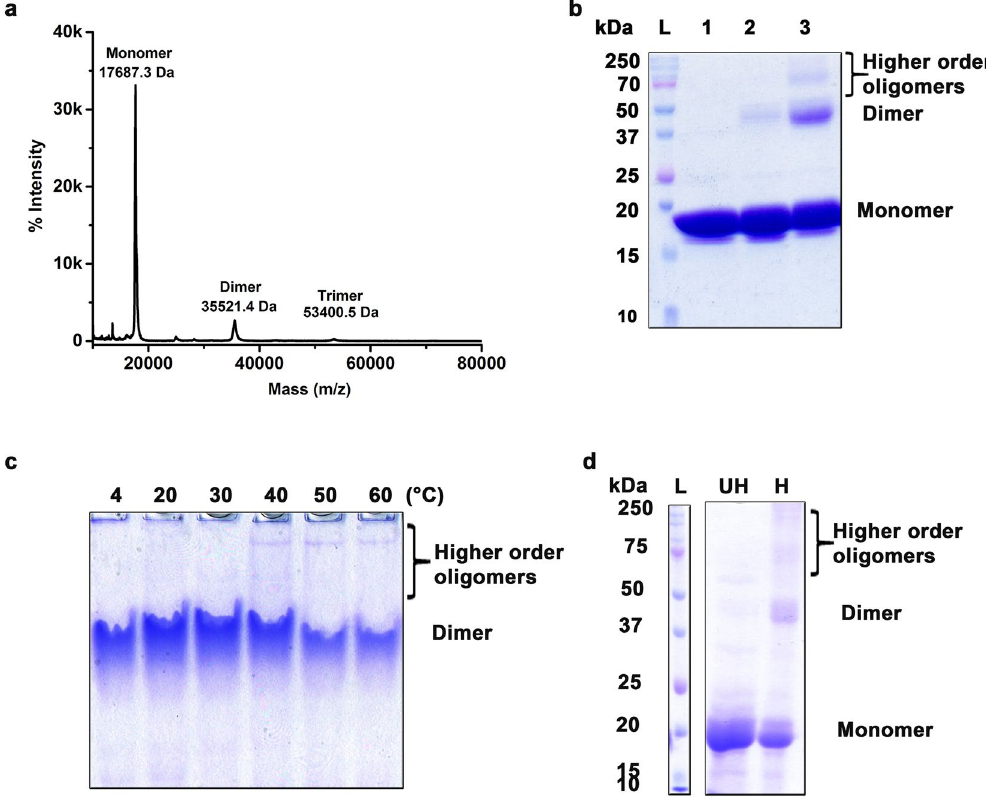
Figure 5. CarD has the tendency to form higher order oligomers in solution. ( a ) MALDI-TOF based intact mass spectrum analysis of CarD (50 μ M) shows the presence of monomeric (17.687 kDa), dimeric (35.521 kDa) and trimeric (53.400 kDa) species. ( b ) Chemical cross-linking experiments performed using BS 3 demonstrates that CarD (50 μ M) has a tendency to form dimers, and higher order oligomers in solution. Lane 1, CarD in absence of BS 3 ; lane 2, and 3, CarD in presence of 30-fold and 50-fold molar excess of BS 3 respectively. L denotes the molecular weight ladder used as a standard. ( c ) CarD samples (50 μ M) were incubated at 4, 20, 30, 40, 50, and 60 °C for 30 min and resolved in the native-PAGE (10%). Native-PAGE analysis suggests the formation of higher order oligomers with increase in temperature. ( d ) SDS-PAGE analysis of the thermally induced higher order oligomers of Mtb CarD (50 μ M). L denotes the molecular weight ladder. UH and H represent the unheated and heated protein samples of CarD, indicating the formation of SDS-resistant dimers and higher order oligomers in the gel. The un-cropped images of the gels shown in b–d are provided in Supplementary Fig.